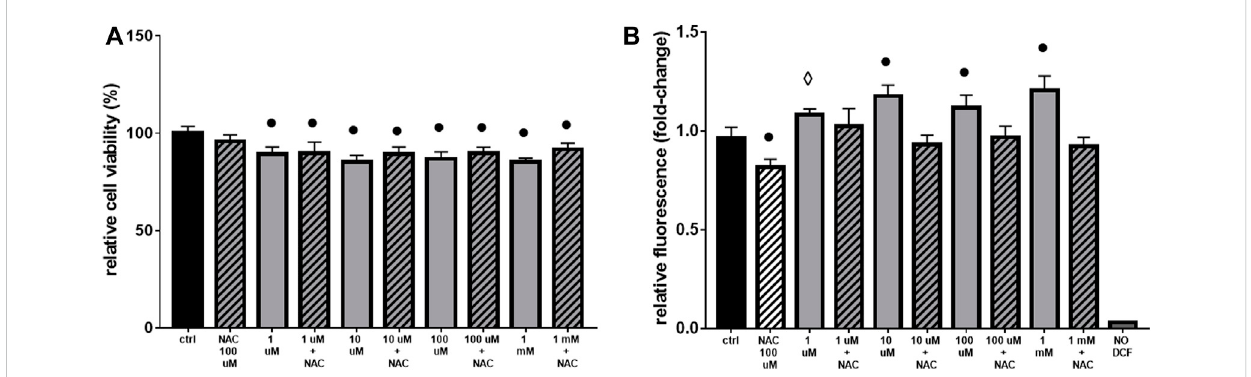
FIGURE 6 Cell viability and ROS production. The fi gure shows the histograms obtained from: (A) MTT and (B) DCF-DA assays. H9c2 cells were treated with 1 μ M to 1 mM of glyphosate and/or 100 µM of NAC for 2 h. After the treatments, cell viability and ROS production were assessed, respectively, through MTT and DCF-DA assays. Mean ± SD; p -values: ◇ < 0.005; ○ < 0.0005; C < 0.0001 vs. control. NO DCF: control lane without the fl uorescent probe.